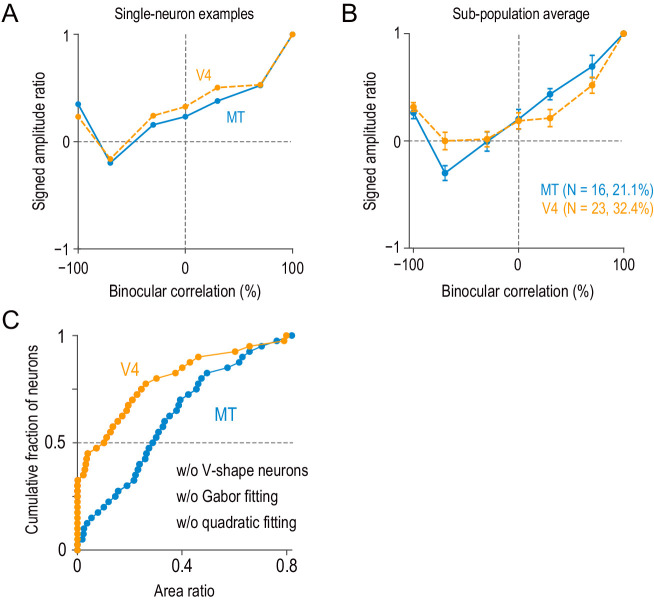
Neurons with V-shape signed amplitude-ratio functions.(A) Example single neurons with V-shape signed amplitude-ratio functions. The signed amplitude ratios were calculated based on the Gabor functions fitted to disparity-tuning data (we did not use the peak-to-trough difference of raw disparity-tuning data because it was more susceptible to neuronal noise). (B) The average signed amplitude-ratio functions for the subpopulation of neurons similar to the examples in (A) (i.e., neurons with positive values at −100% correlation and negative minima at correlation levels above −100%). The average curve for the V4 subpopulation did not have a large negative minimum, because the location of the minimum varied between −70% and −30% correlations. Error bars indicate ± SEMs. (C) Model-free area-ratio distribution similar to Figure 5—figure supplement 3A but without the subpopulation of neurons summarized in (B). The area ratio significantly differed between MT and V4 (two-sided Mann–Whitney U-test, p=3.3 × 10−5 for the median difference; N = 67 for MT, 55 for V4).Figure 5—figure supplement 4—source data 1.Signed amplitude ratios from Gabor-function disparity tuning.Neurons with strong violation (see Appendix 1—Figure 5—text supplement 1) are flagged.